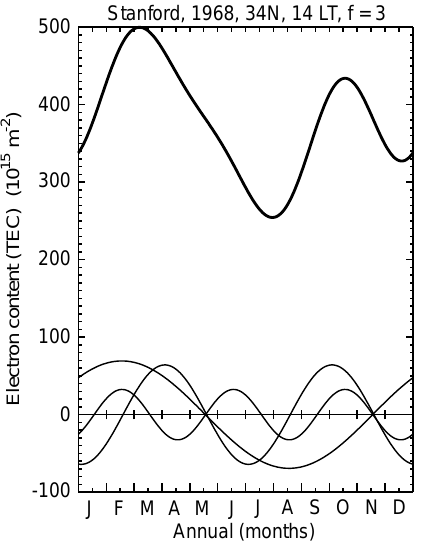
Fig. 6. Annual variation of ionospheric electron content (TEC) from four Fourier components (mean, 1 year, 1/2 year, 4 months). The latter three components are shown separately ( thin lines ). Intermediate level of solar activity (103 (cid:20) R 12 (cid:20) 111), solar cycle 20. Data from the Faraday e(cid:128)ect on the VHF signals of the geostationary satellite ATS- 1, receiving station Stanford, USA. Bi-hourly monthly medians